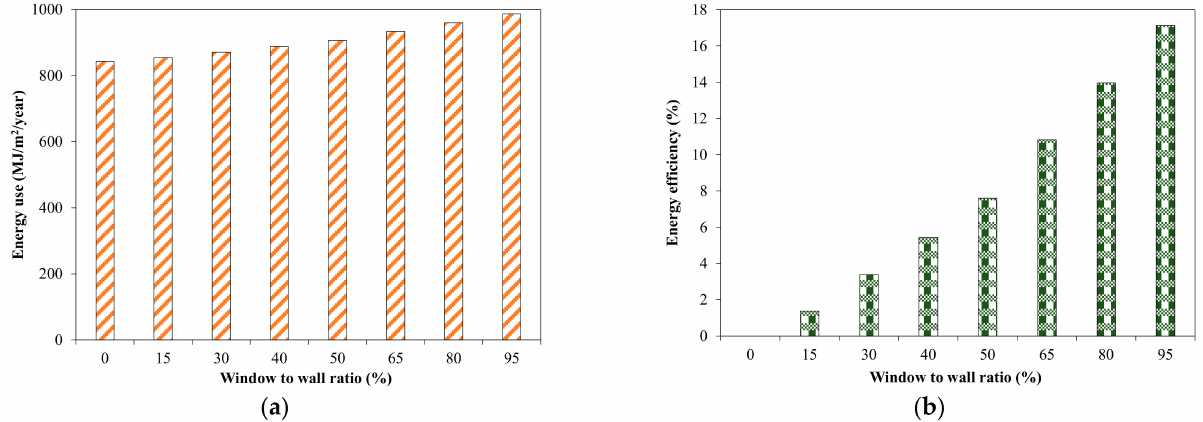
Figure 18. Effect of W/W ratio in energy use in tested office building. ( a ) Energy use; ( b ) Efficiency.